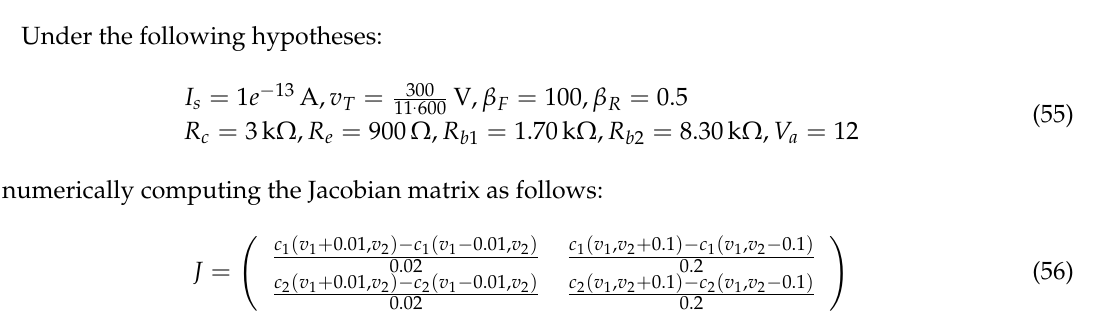
ˆ v and ˆ( ) c v for several